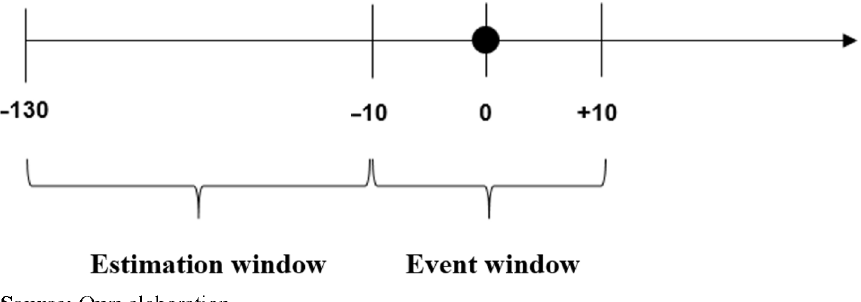
Figure 1. Estimation and event